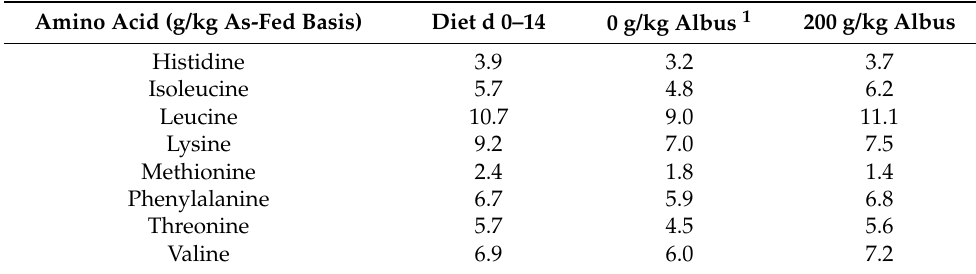
Table 2. Amino acid composition of the